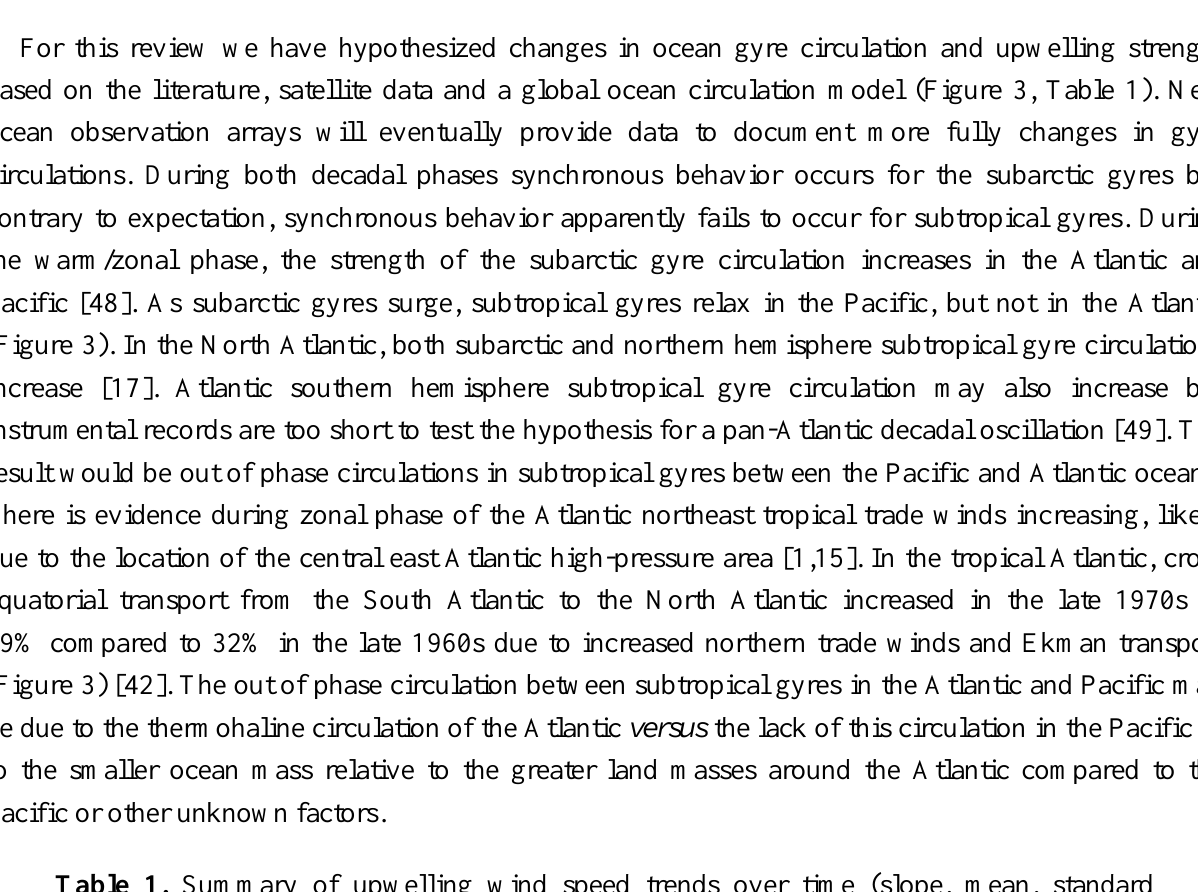
Table 1. Summary of upwelling wind speed trends over time (slope, mean, standard deviation (SD) and tendency), temperature tendency, chlorophyll tendency for early 2000s. n.d: no